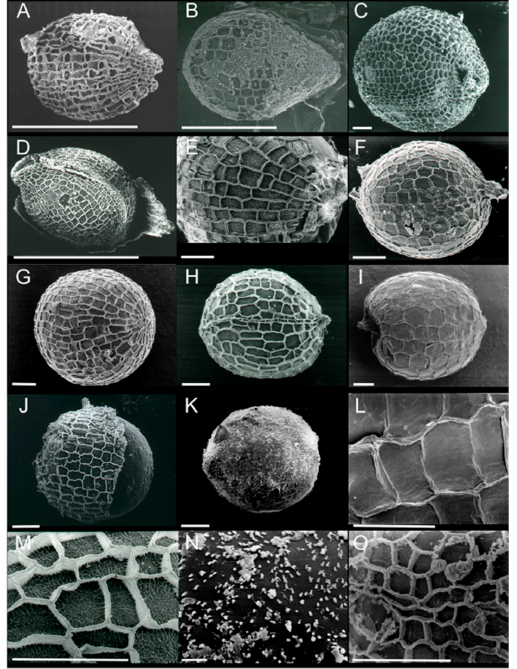
Figure 1. SEM Micrographs of seed surface in selected Halophila species ( A ): H. australis : SW Australia (UWA), scale bar = 1 mm., ( B ): H. ovalis : SW Australia (UWA), scale bar = 1 mm., ( C ): H. ovalis : Sri Lanka, Meijer 782 (L), scale bar = 0.1 mm., ( D ): H. madagascariensis : Madagascar, Bathie 14236 (P), scale bar = 1 mm., ( E ): H. stipulacea : Elate Gulf, Lipkin 10174 , scale bar = 0.1 mm., ( F ): H. decipiens : Jamaica, Throne 48288 (NY), scale bar = 0.1 mm., ( G ): H. decipiens : SW Australia (UWA), scale bar = 0.1 mm., ( H ): H.decipiens : Okinawa, Japan(UWA),scalebar = 0.1mm., ( I ): H .sp. All. decipiens . NE Australia (W Lee Long), scale bar = 0.1 mm., ( J ): H. decipiens : Martinique, Hahn 1271 (P), scale bar = 0.1 mm., ( K ): H. tricostata : Hinchinbrook Is. (QFH), scale bar = 0.1 mm., ( L ): H. all. decipiens sp.: NE Australia (QFH), scale bar = 0.1 mm., ( M ): H. decipiens : Proto Rico, Howe 7039 (NY), scale bar = 0.1 mm., ( N ): H. tricostata : Queensland, Hinchinbrook Is. (QFH), scale bar = 0.1 mm., ( O ): H. gaudichardii : Guam, Tsuda 3198 (GU), scale bar = 0.1